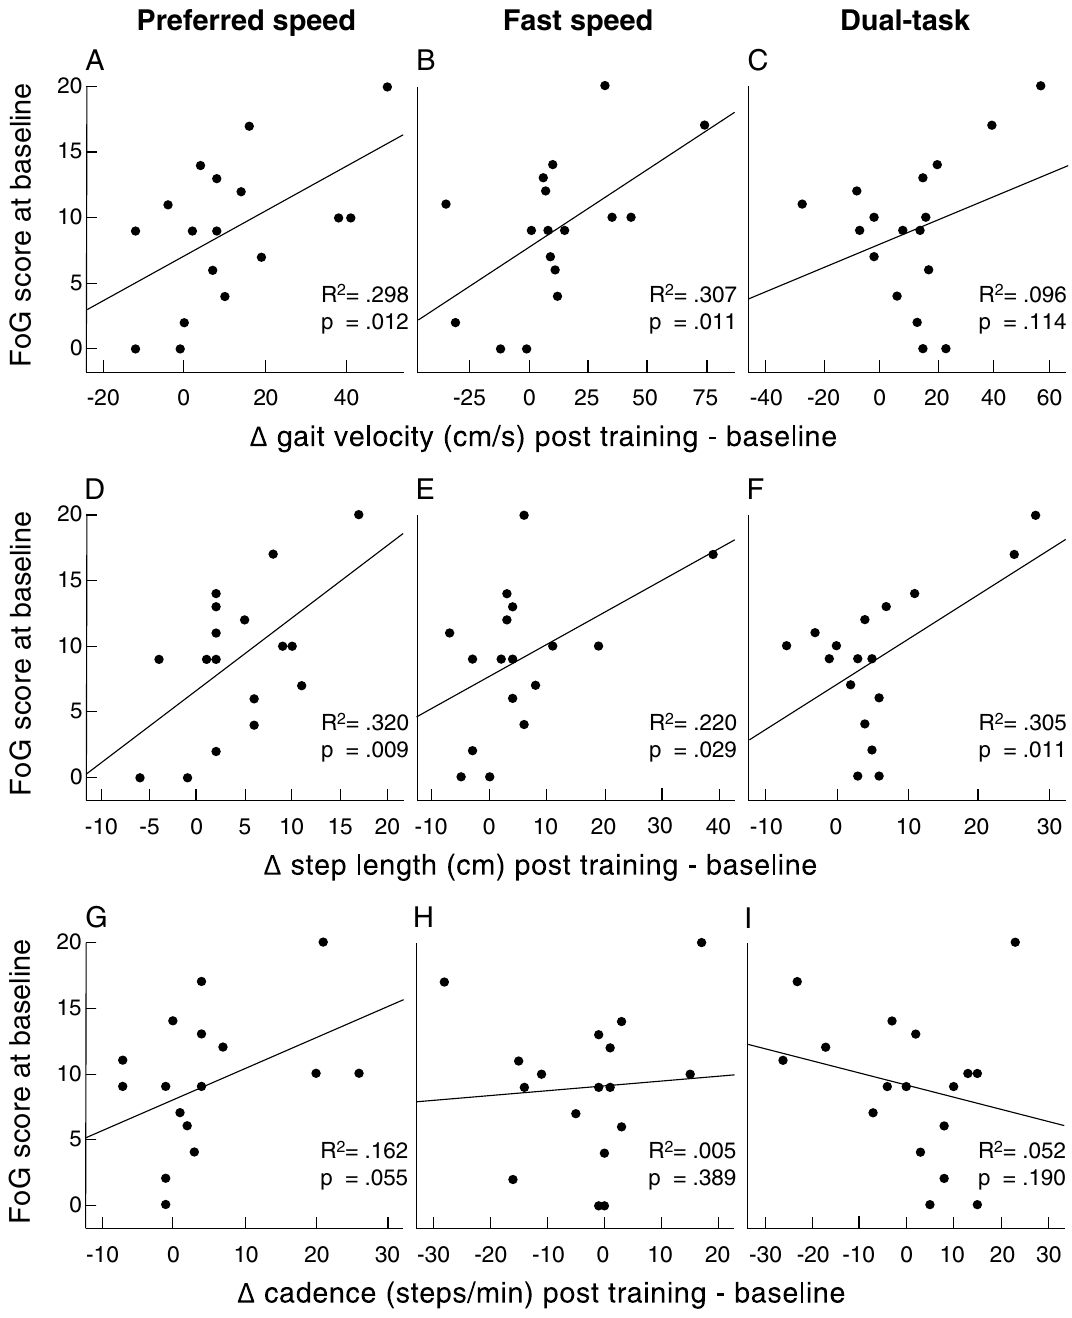
Figure 2. Impact of FOG severity in PD on training